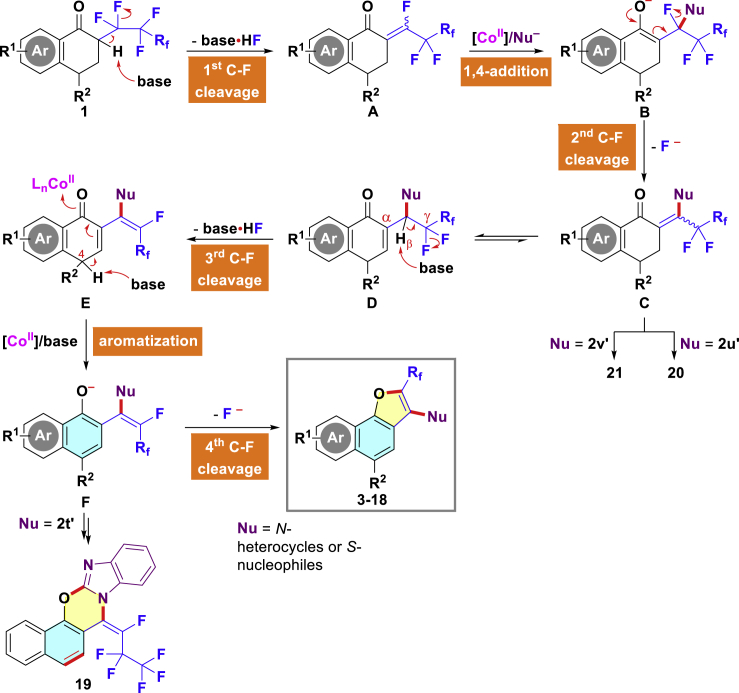
Proposed Mechanism